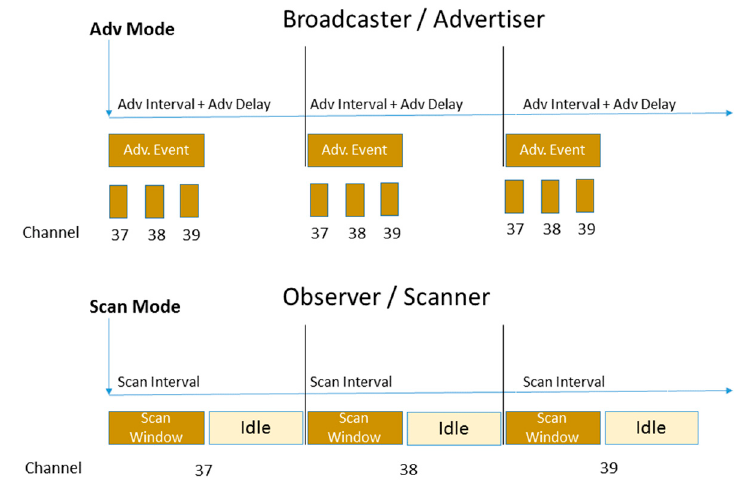
Figure 3. Advertiser/Scanner behaviour.